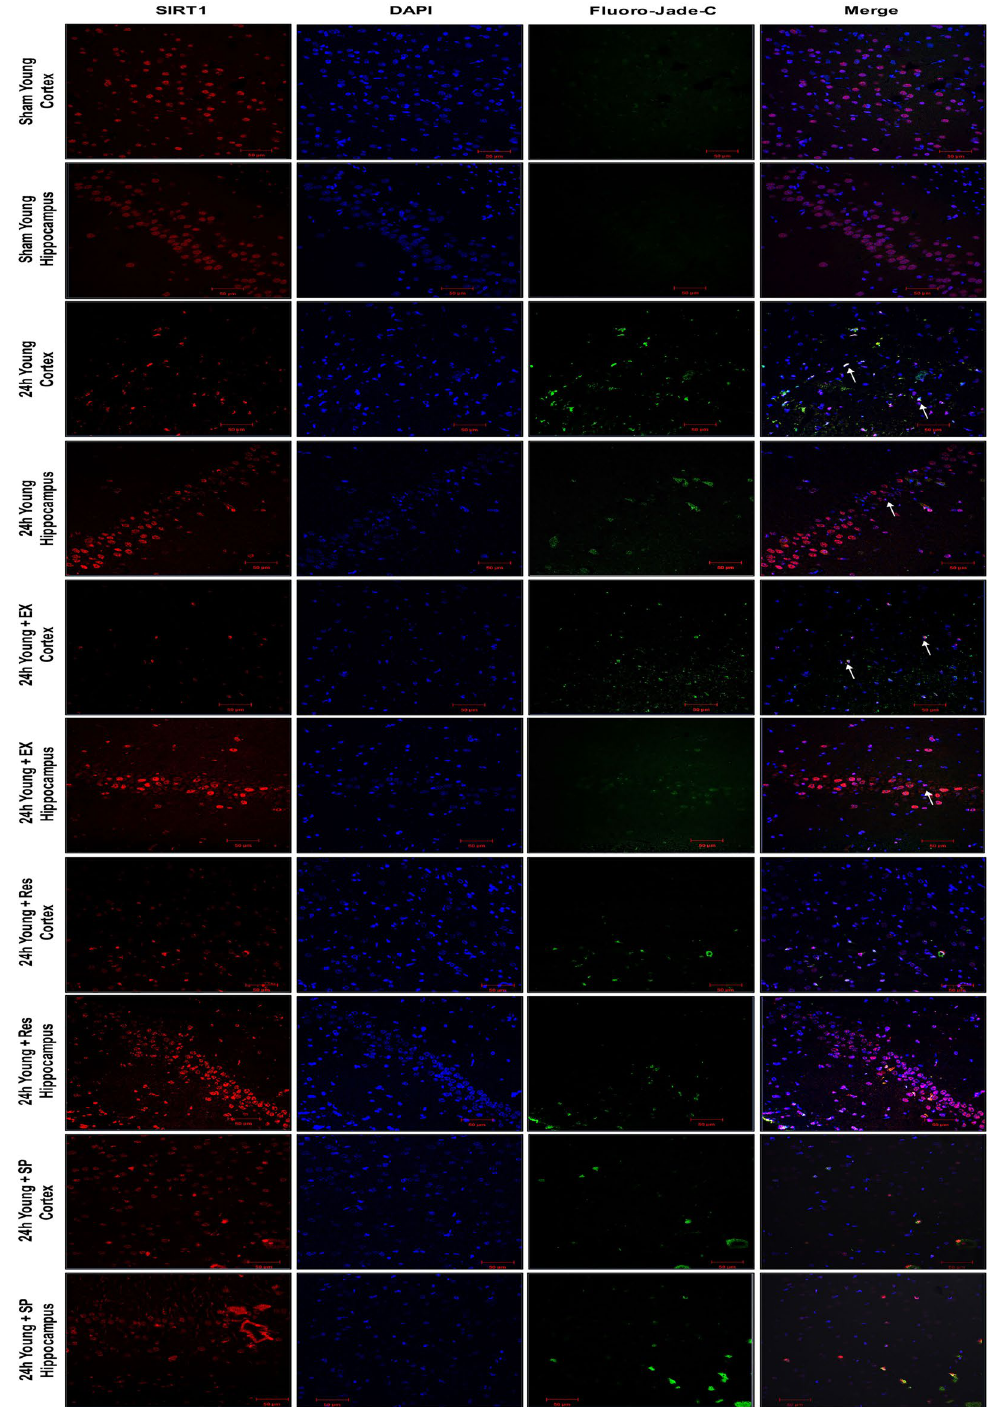
Figure 7. Immunofluorescence labeling of SIRT1 in brains of the young experimental rat. Triple immunofluorescence staining is used to probe for SIRT1 (Red), DAPI (Blue), and Fluoro Jade-C (Green) to assess neurodegeneration in cortex and hippocampus neurons for control as well as brains from 24 h after MCAO, MCAO + EX-527, MCAO + resveratrol, and MCAO + SP600125 treatment. White arrows indicate co-localization of FJ-C with SIRT1 and DAPI (n = 4; Scale Bar—50